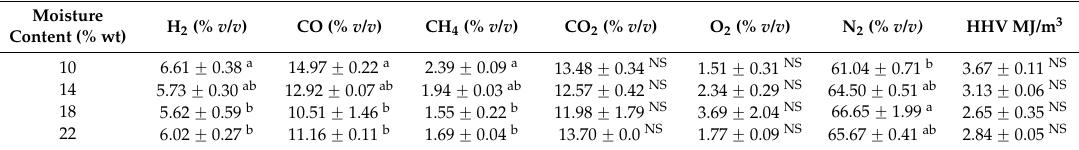
Table 3. Syngas composition and higher heating value of syngas at varying biomass moisture